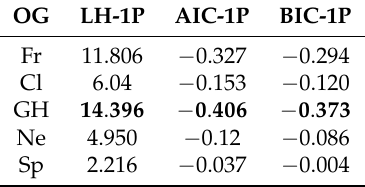
Table 5. Loglikelihood, AIC and BIC values for the old generation, one-parameter